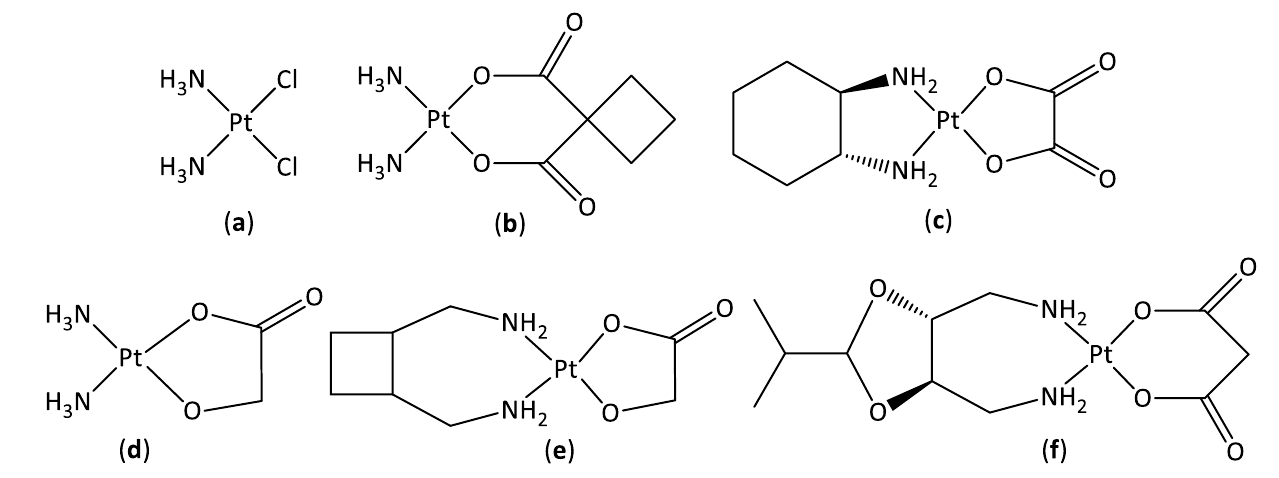
Figure 1. The chemical structures of cisplatin ( a ), carboplatin ( b ), oxaliplatin ( c ), nedaplatin ( d ), lobaplatin ( e ), and heptaplatin ( f ).